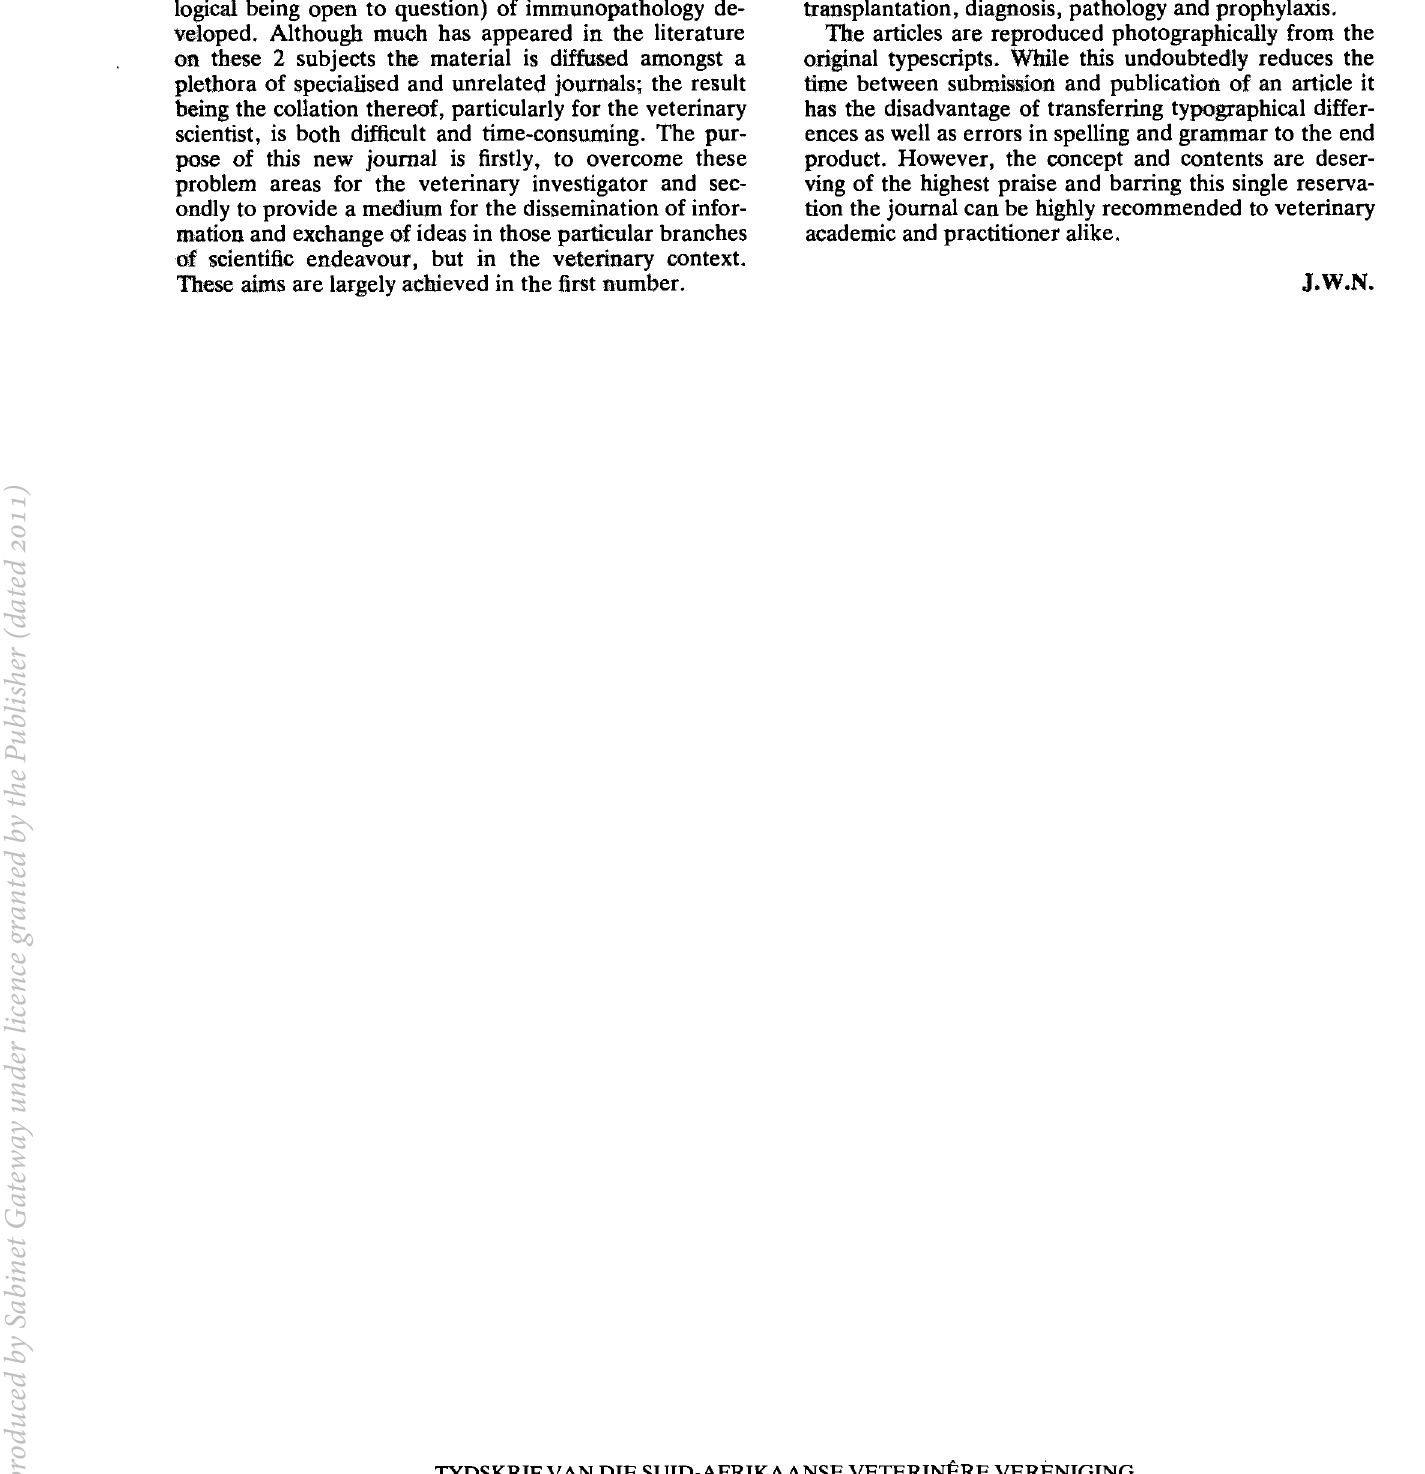
TYOSKRIF VAN DIE SUID-AFRIKAANSE VETERINERE